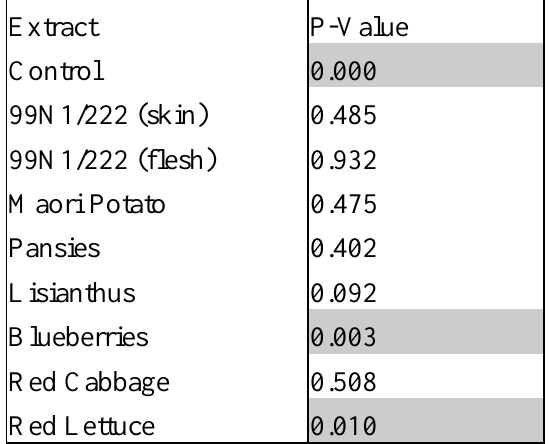
Table 5 . P-values determined from unpaired t-tests for tail extent moment comparing the 0 ºC and 37 ºC H O treatment groups. Shaded boxes represent significant differences (p  2 2